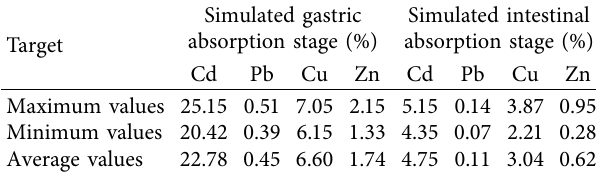
Table 4: Bioavailability of simulated intestinal and gastric stages.